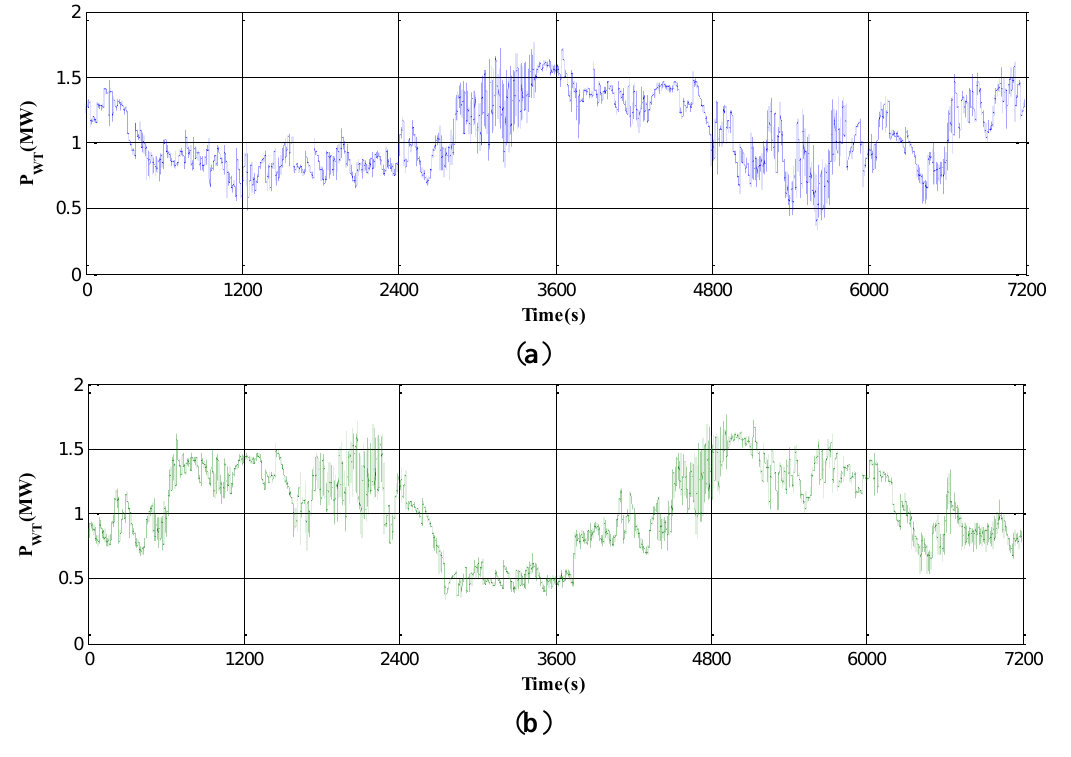
Figure 9. Active power output of wind turbine sampled at 1-s resolution: ( a ) Wind Pattern 1; and ( b ) Wind Pattern